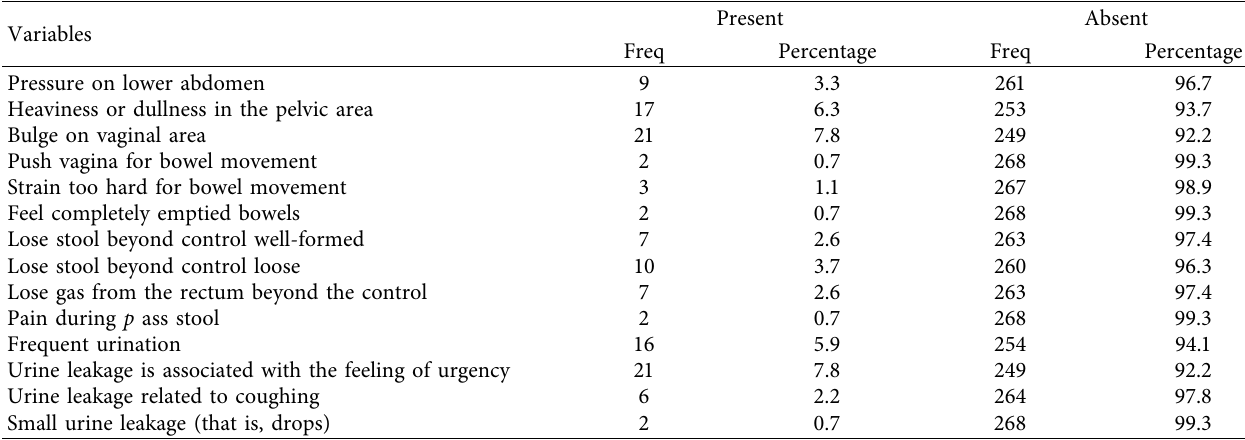
Table 5: Outcome distress symptom responses related to PFD among study participants.